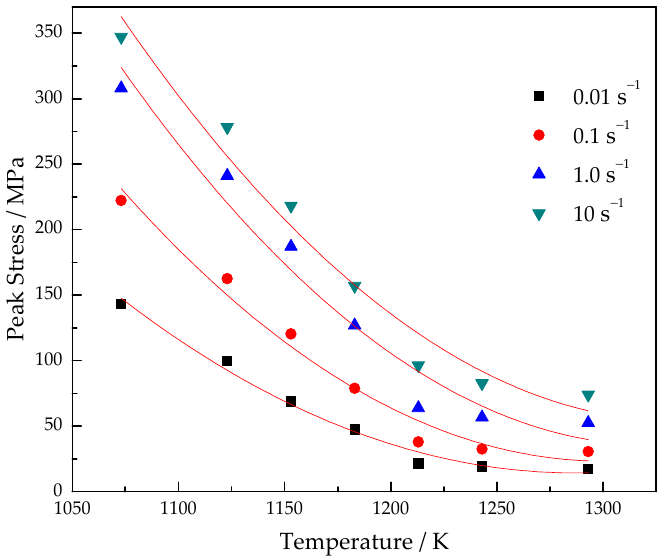
Figure 5. Peak stress of Ti–3.3Al–1.5Zr–1.2Mo–0.6Ni titanium alloy at different deformation parame ‐